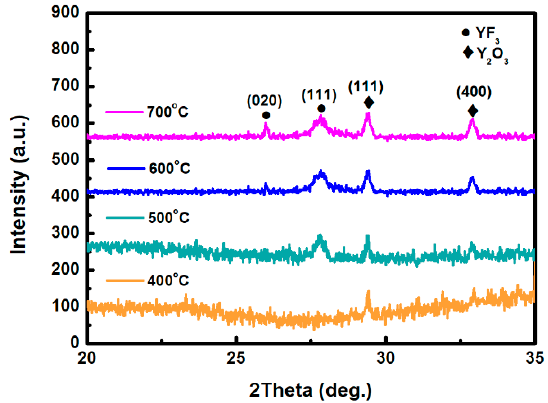
Figure 1. XRD patterns of the as-deposited yttrium fluoride (YF 3 ) films grown at 400, 500, 600, and 700 °C.